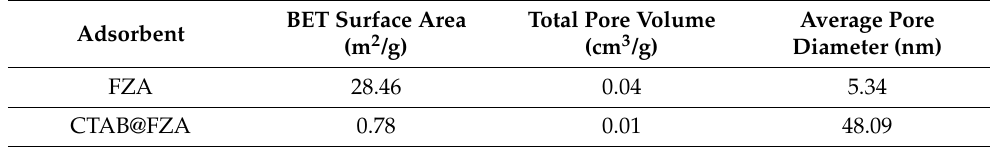
Table 1. Surface textural properties of CTAB@FZA and FZA.